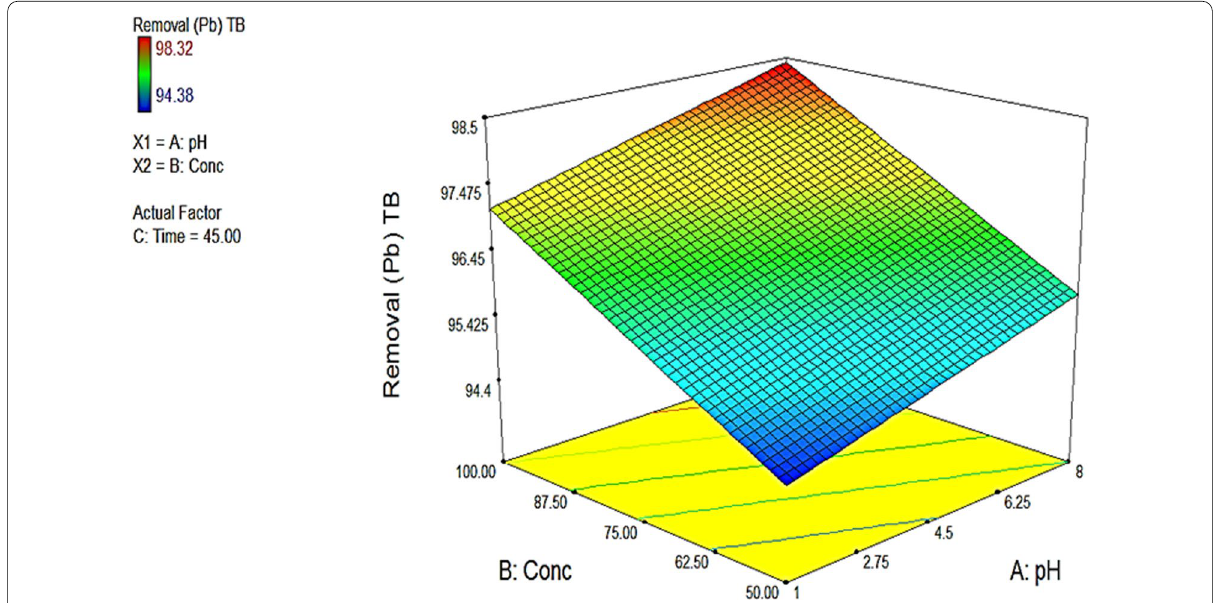
Fig. 1 A 3-dimensional plot of concentration and pH against the percentage removal of lead when tea bag residues are used as